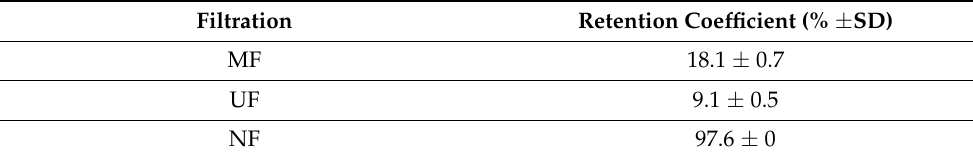
Table 1. Retention coefficients calculated from detected, normalised SH peak areas.